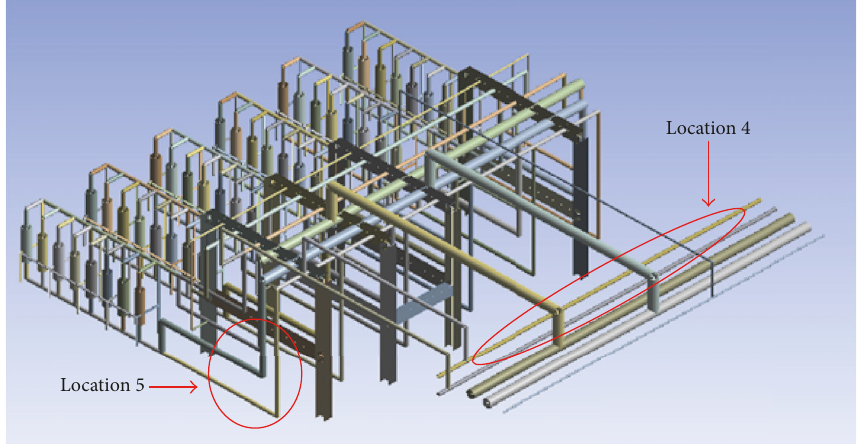
Figure 15: Critical locations of vibration.